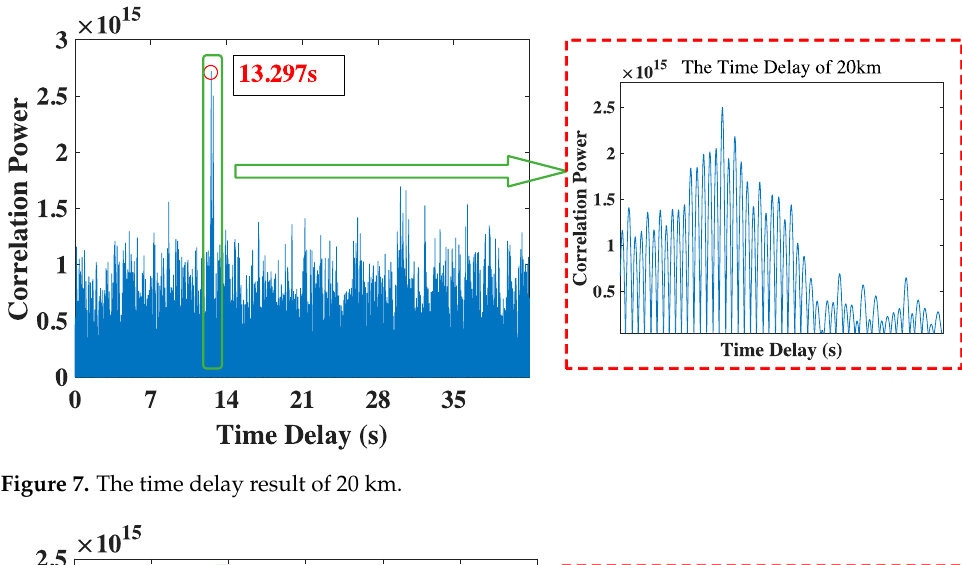
Figure 6. The time delay result of 10 km.